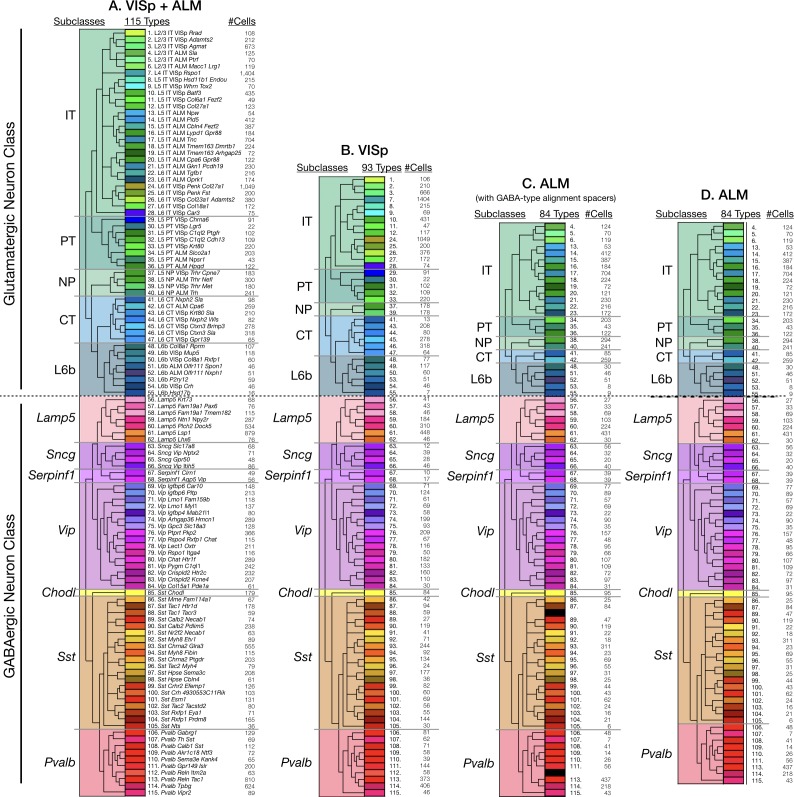
Tasic 2018 neurotaxonomy.Tasic and co-workers (Tasic et al., 2018, Nature
563:72–78) generated the hierarchical taxonomy of glutamatergic and GABAergic neurons represented here by dimensionality reduction and iterative hierarchical clustering of data from single-cell RNA-Seq analysis of 22,439 mouse cortical neurons dissociated from areas VISp (13,491 neurons) and ALM (8948 neurons). This neurotaxonomy is rendered here in four different forms as used in Figures 3–7 to specify Tasic 2018 neuronal cell ‘types’ and/or ‘subclasses’ as indicated by column headings. Each rendering represents a Tasic 2018 cladogram, five glutamatergic subclasses, 6 GABAergic subclasses (since Chodl is a singular type, it is not counted as a subclass) and some number of neuron types. The rectangle fill colors and orderings here are used consistently in Figures 3–7 to denote neuronal subclasses and types: the deep color fills for the small type rectangles are as introduced by the Tasic 2018 publication; the pastel color fills for the larger subclass rectangles are derived by averaging and fading the deeper color fills of the types within each subclass. The Tasic 2018 type numbers, names (panel A only) and counts of cells clustered to each type are tabulated here. (A) 11 subclasses and 115 types clustered from single-cell RNA-seq transcriptomes from cells aggregated across VISp and ALM areas. (B) 11 subclasses and 93 types found in VISp neurons. (C) 11 subclasses and 84 types found in ALM neurons. Because most GABAergic types (58 out of 60) are shared between VISp and ALM, spacers (black-filled rectangles) are placed in this rendering between types 87 and 89 and types 111 and 113 to maintain linear registration of GABAergic types between VISp and ALM types in spite of absence of types 88 and 112 in ALM. (D) 11 subclasses and 84 types found in ALM neurons (without registration-preserving spacers).